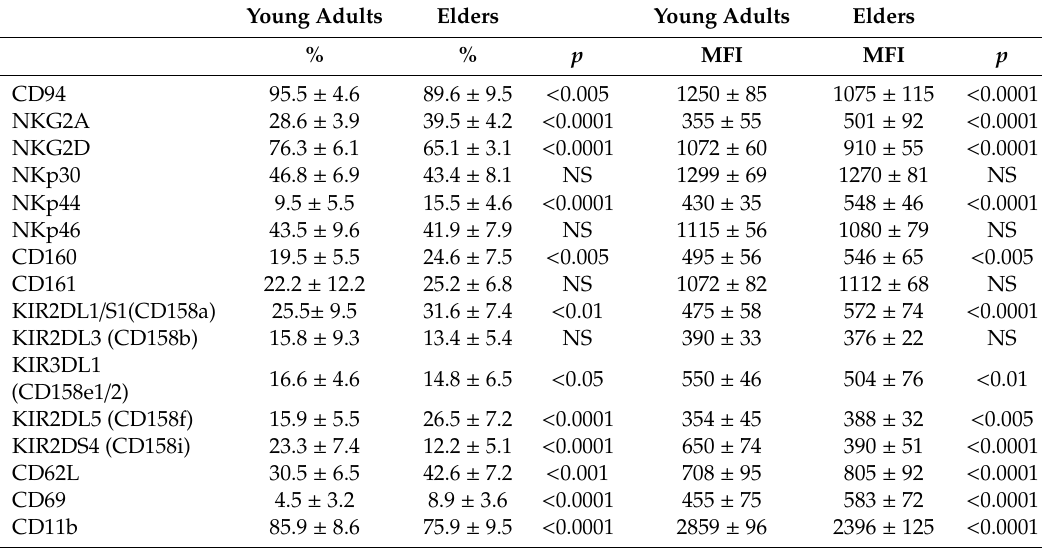
Table 2. Expression of Killing Inhibitory Receptors (KIR) and activating receptors in NK cells derived from young adults and elders. The results represent the percentage mean and SD and Mean Channel Fluorescence Intensity (MFI) in linear units for each group ( n = 30). The statistical analysis was accomplished using the paired Student’s t -test in both parameters analysed. Young Adults Elders Young